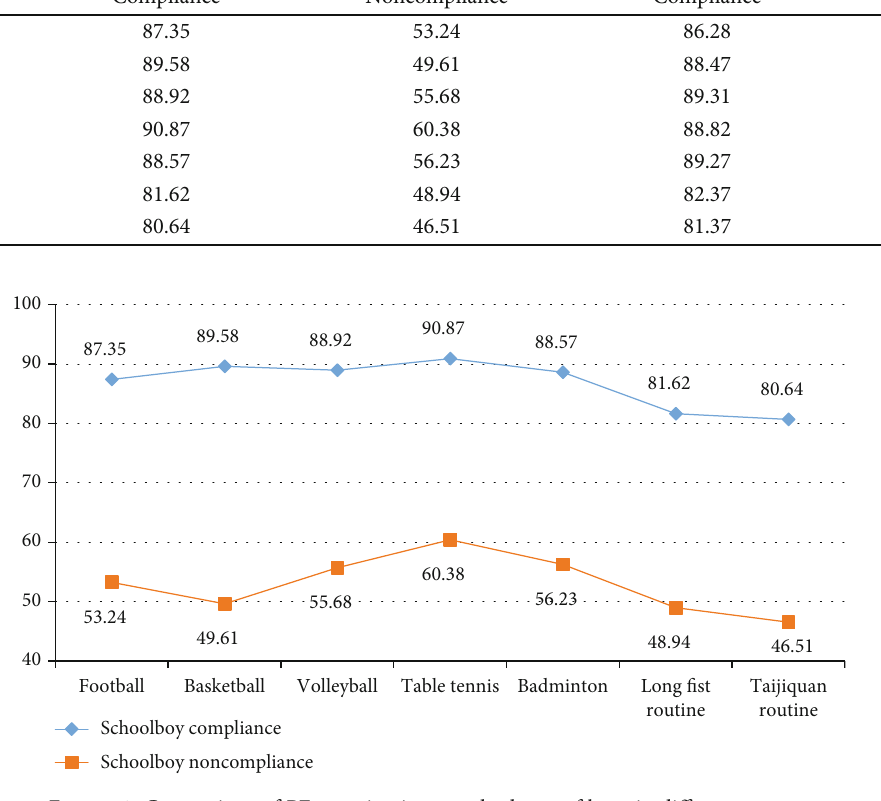
Figure 1: Comparison of PE examination standard rate of boys in di ff erent groups.